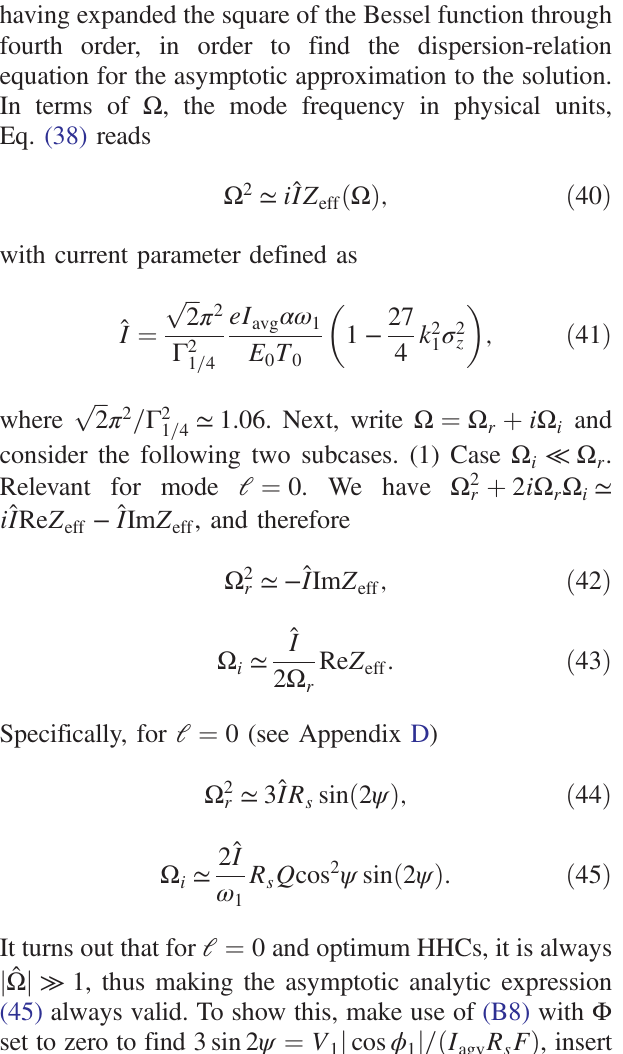
TABLE III. Numerical solutions of the approximate dispersion- relation equation (38). Optimal